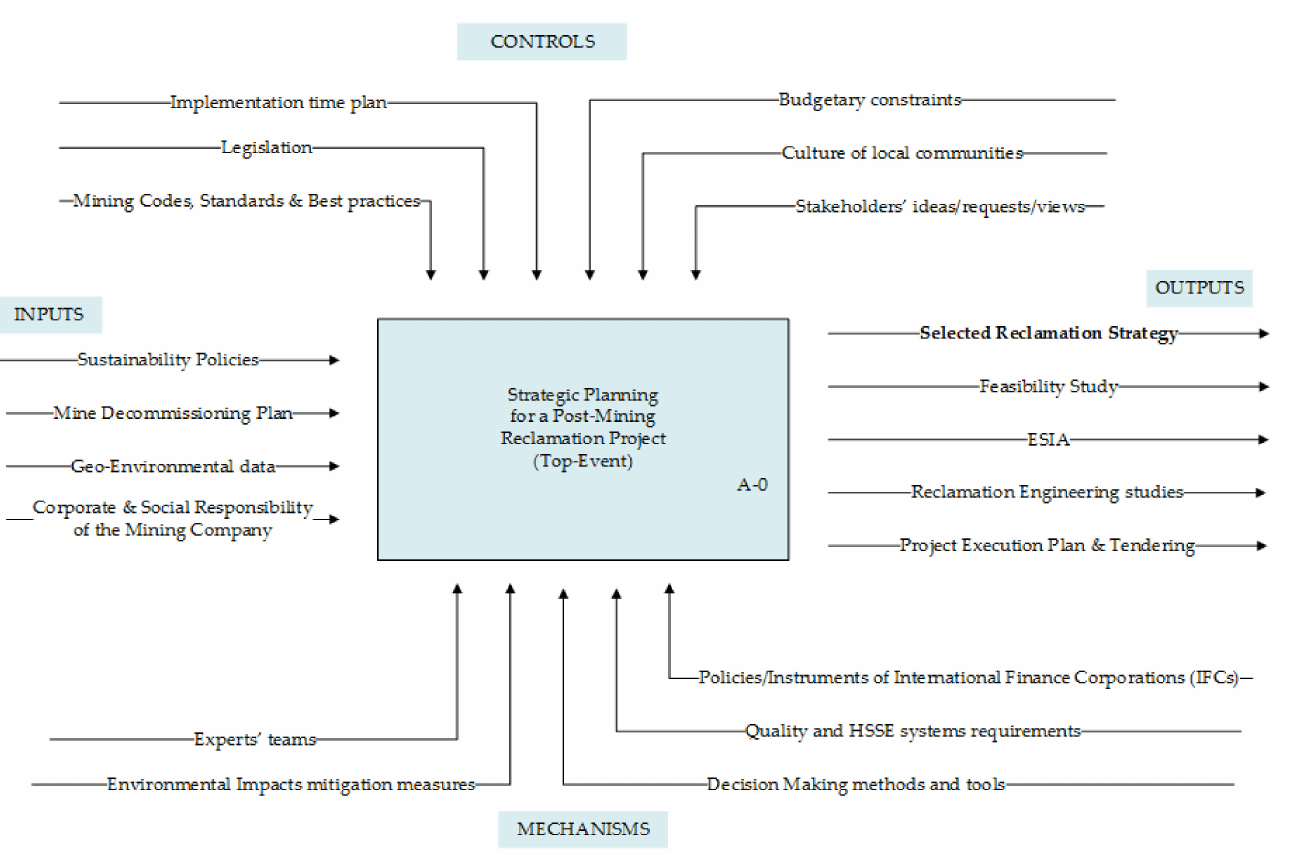
Figure 3. The top event/A-0 of the IDEF0 process